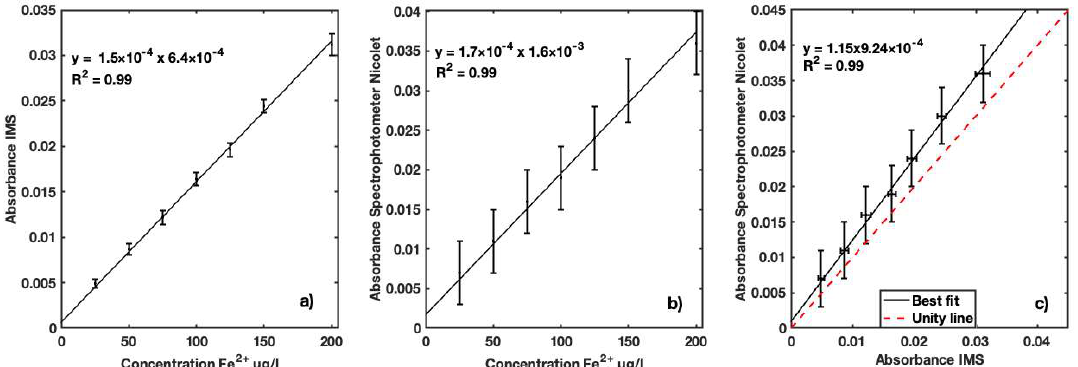
Figure 13. ( a ) Calibration curve of Fe 2+ for IMS instrument for natural freshwater samples collected in a dam in concentrations ranging between 25 and 200 µg/L; ( b ) calibration curve of Fe 2+ for same sample concentrations for reference Nicolet Evolution 300 spectrophotometer; ( c ) best fit of absorption coefficients measured with the two instruments for performance comparison. The results for the IMS, averaged over 30 measurements per sample, the measure- ment absorbance for the Nicolet Evolution 300, and the variance for the IMS are presented in Table 6. Absorbance values vary linearly with increasing Fe 2+ concentration in the pre- pared standard samples. A slight increase in absorbance values is noted compared with the results obtained in the second series, indicating the presence of Fe 2+ in the original freshwater samples from a dam. Table 6. Measurements of absorbance in third series of iron standard samples. Sample Conc.